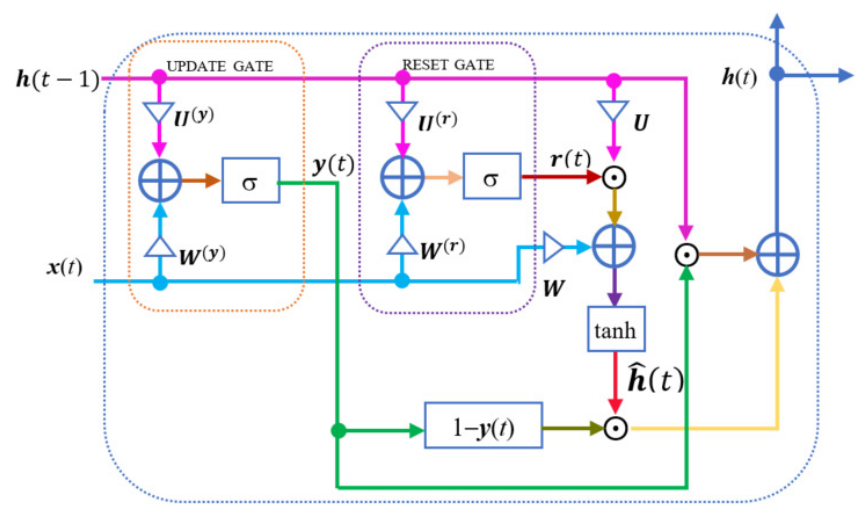
Figure 5. Gated Recurrent Unit.